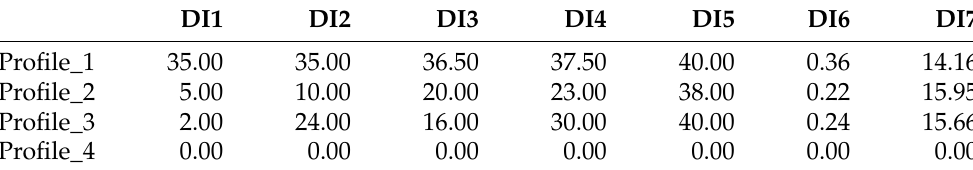
Table 4. Values of seven indices for differentiation on four different types of score